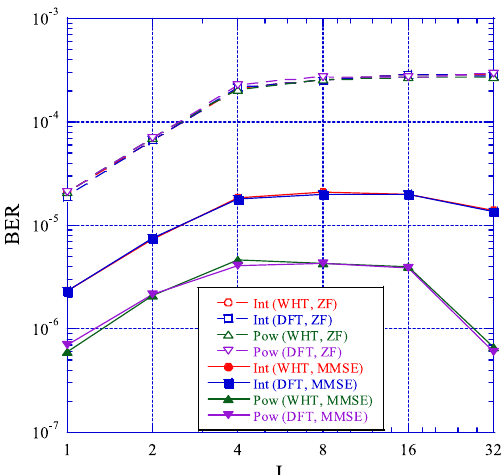
Fig. 7 BER of the various I for the interleaved block subcarrier allocation and the power combination with the WHT, the DFT, the ZF, and the MMSE, without the coding at E b / N 0 = 25